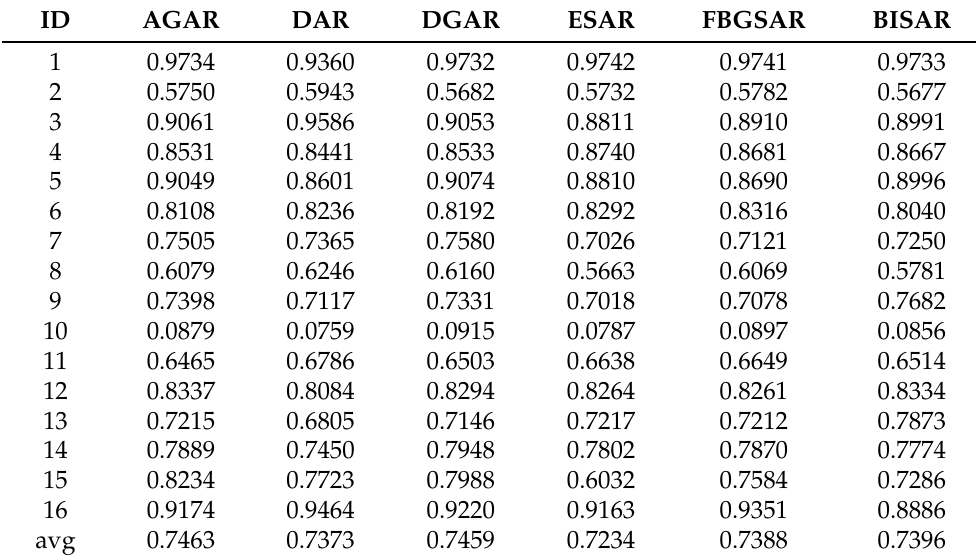
Table 10. Classification accuracies based on the KNN classifier (feature noise).